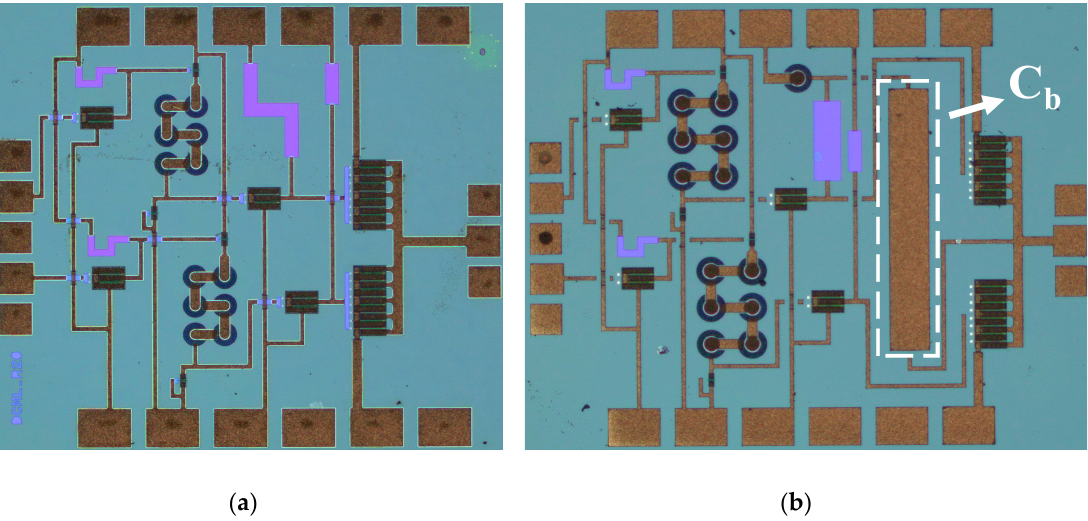
Figure 10. Photos of the convertor chip prototype of: ( a ) convertor without a bootstrapped capacitor, 1.7 mm × 1.3 mm, and ( b ) convertor with a bootstrapped capacitor, 1.7 mm × 1.3 mm.